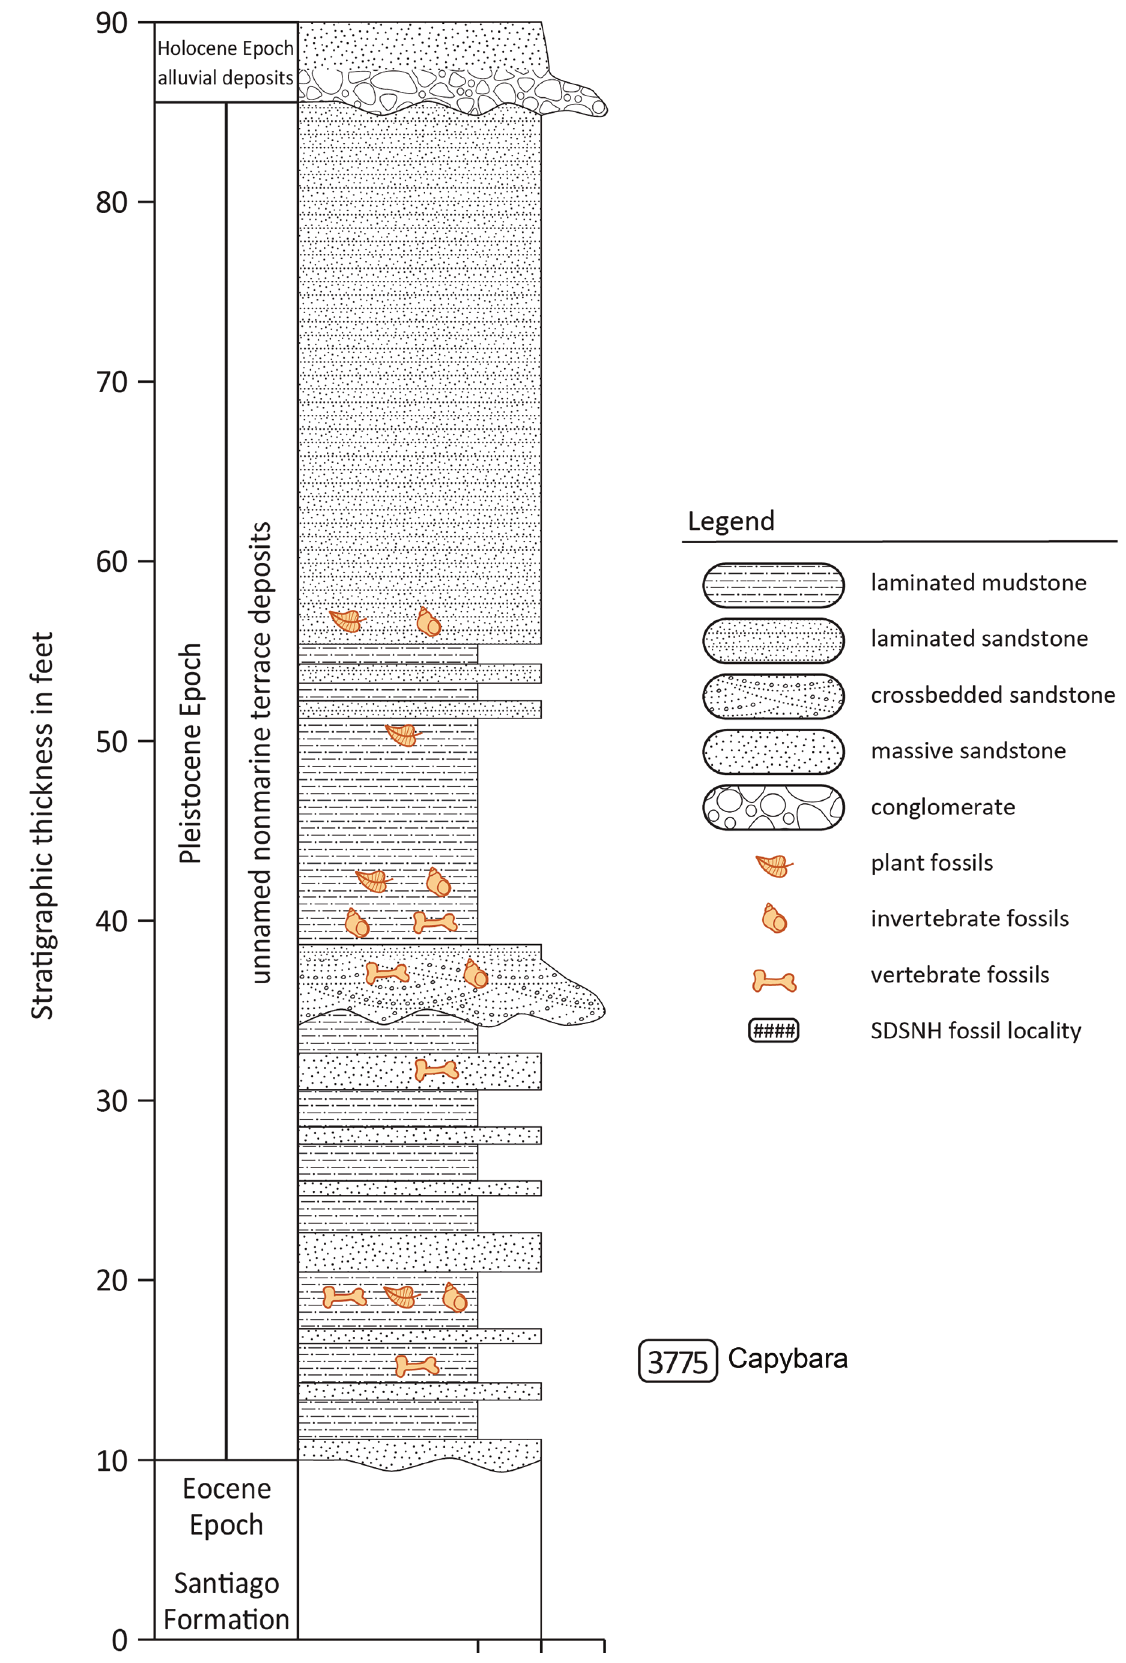
Figure 4. Stratigraphic section for SDSNH locality 3775 Oceanside, San Diego County, California,